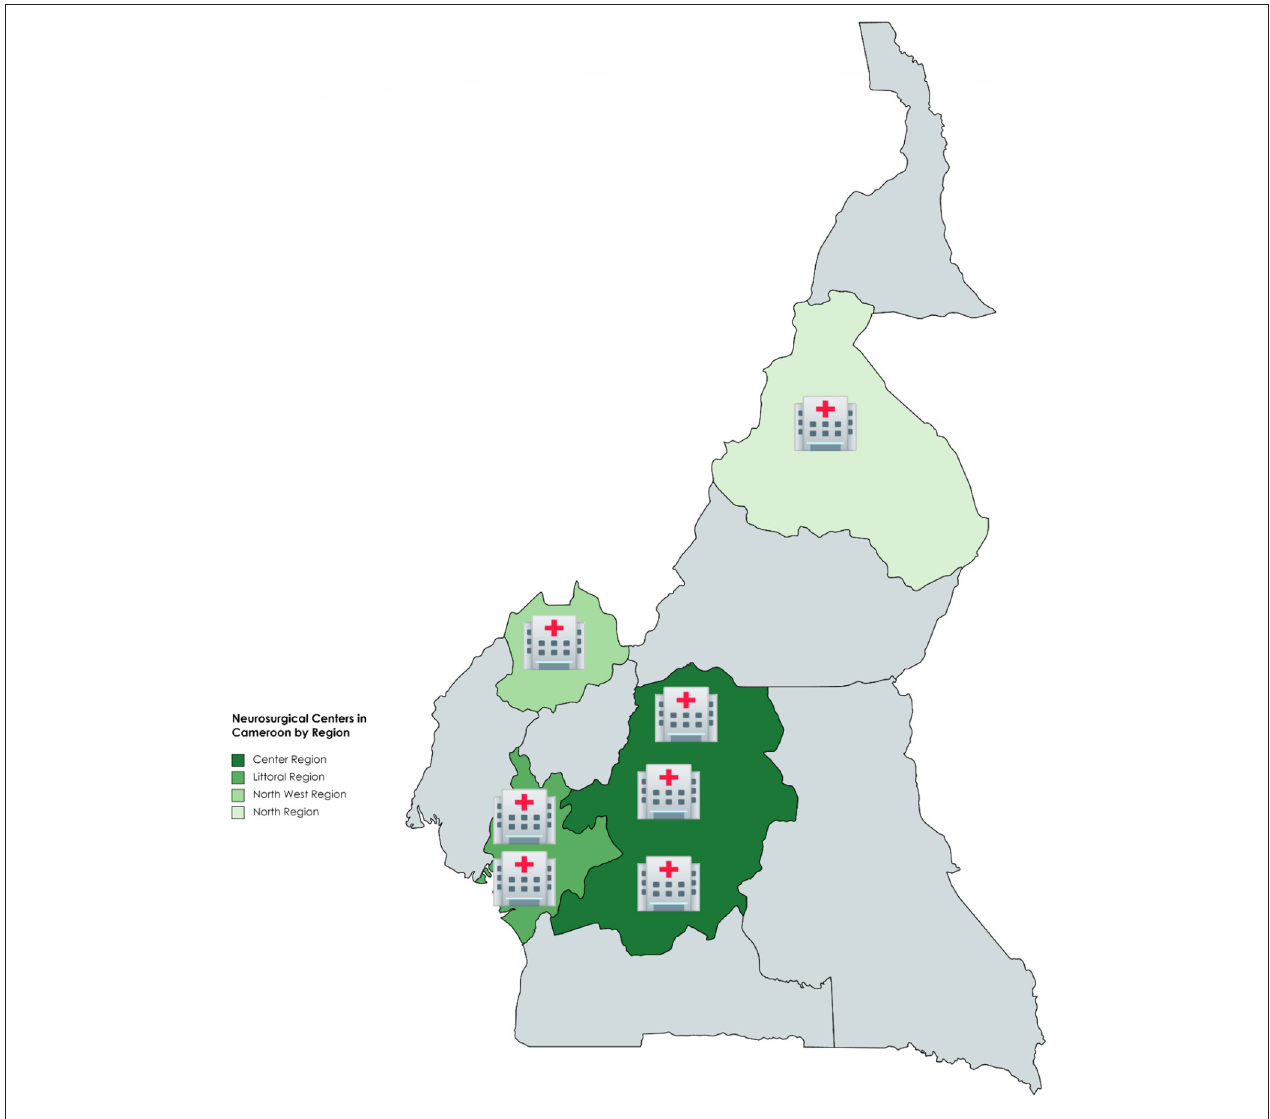
FIGURE 1 | Neurosurgical Centers in Cameroon by